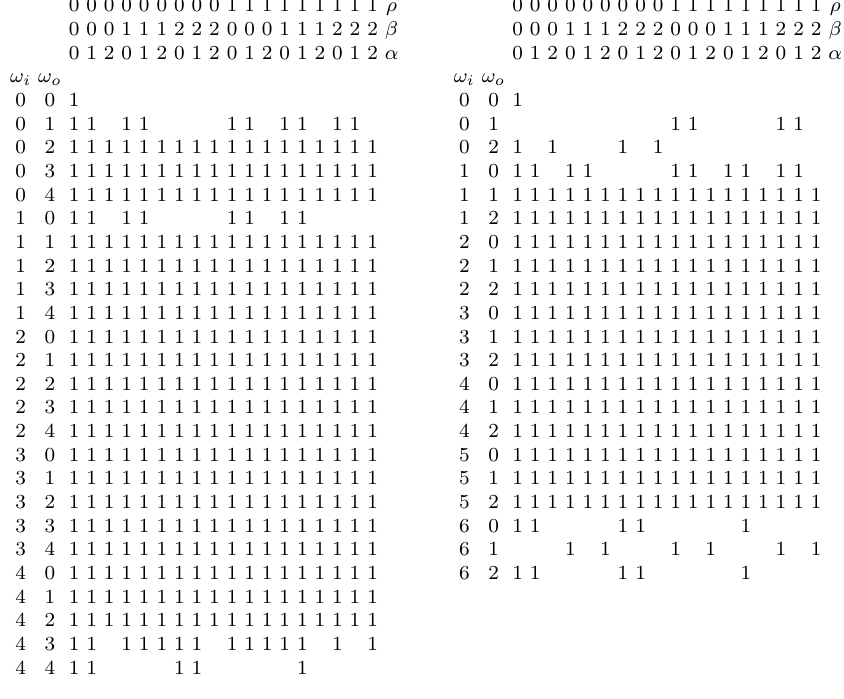
Figure 17: Vulnerability profiles of DOM without (left) and with (right) output register for d = 1 ( s =